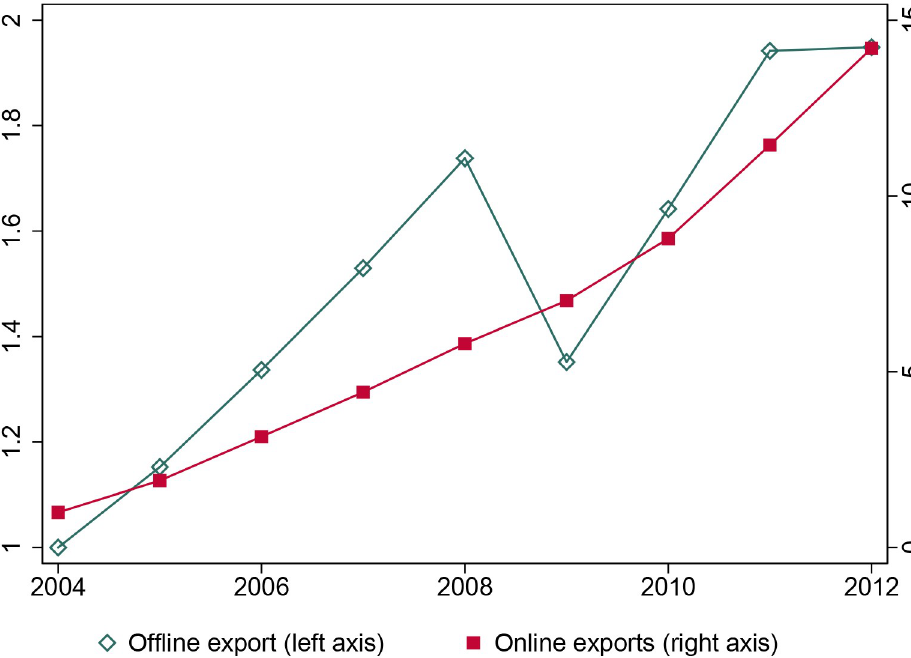
Fig 1. Evolution of world and online cross-border trade, 2004-2012. This is the partial plot of a regression of the log of the wage gap between skilled and unskilled workers on a time trend and country fixed effects for countries in our sample with more than 7 observations over the period